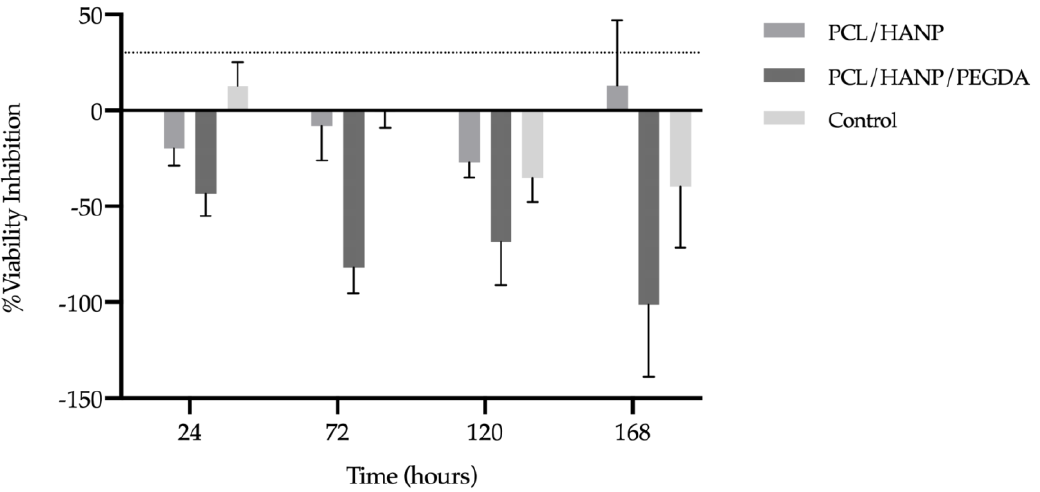
Figure 10. % Viability inhibition evaluated by PrestoBlue ® viability assay for hDPSCs after 24, 72, 120 and 168 h. Results are normalised to the PCL as 0%. The 30% threshold shown in the graph (dashed line) represents the inhibition above which the effect is considered cytotoxic (in accordance with ISO 10993-5:2009 guidelines).